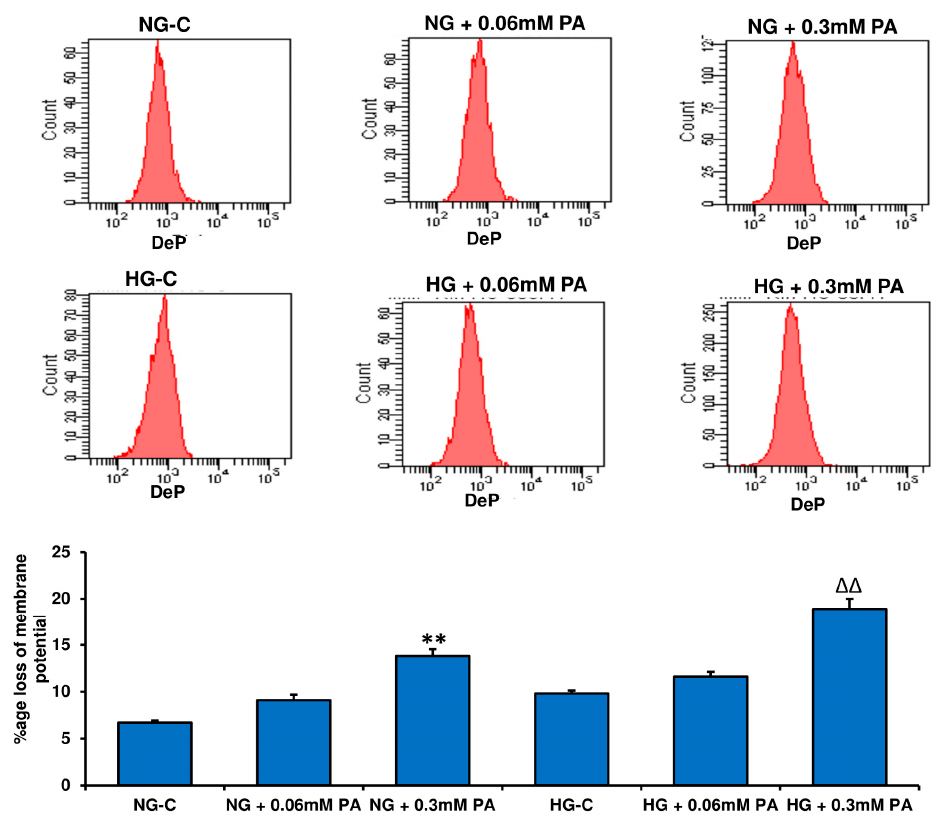
Figure 8. E ff ect of high glucose / high palmitic acid (HG / HPA) on mitochondrial membrane potential. HepG2 cells were treated with high glucose and high fatty acids, and mitochondrial membrane potential was measured by flow cytometry using a fluorescent cationic dye according to the vendor’s protocol (DePsipherTM, R &D System Inc.). A typical histogram representing the percentage loss of mitochondrial membrane potential is shown. Results are expressed as mean +/ − SEM of three experiments. Asterisks indicate significant di ff erences (** p ≤ 0.005) relative to untreated control cells under normal glucose condition (NG-C), and triangles indicate significant di ff erences ( ∆∆ p ≤ 0.005) relative to untreated control cells under high glucose condition (HG-C).